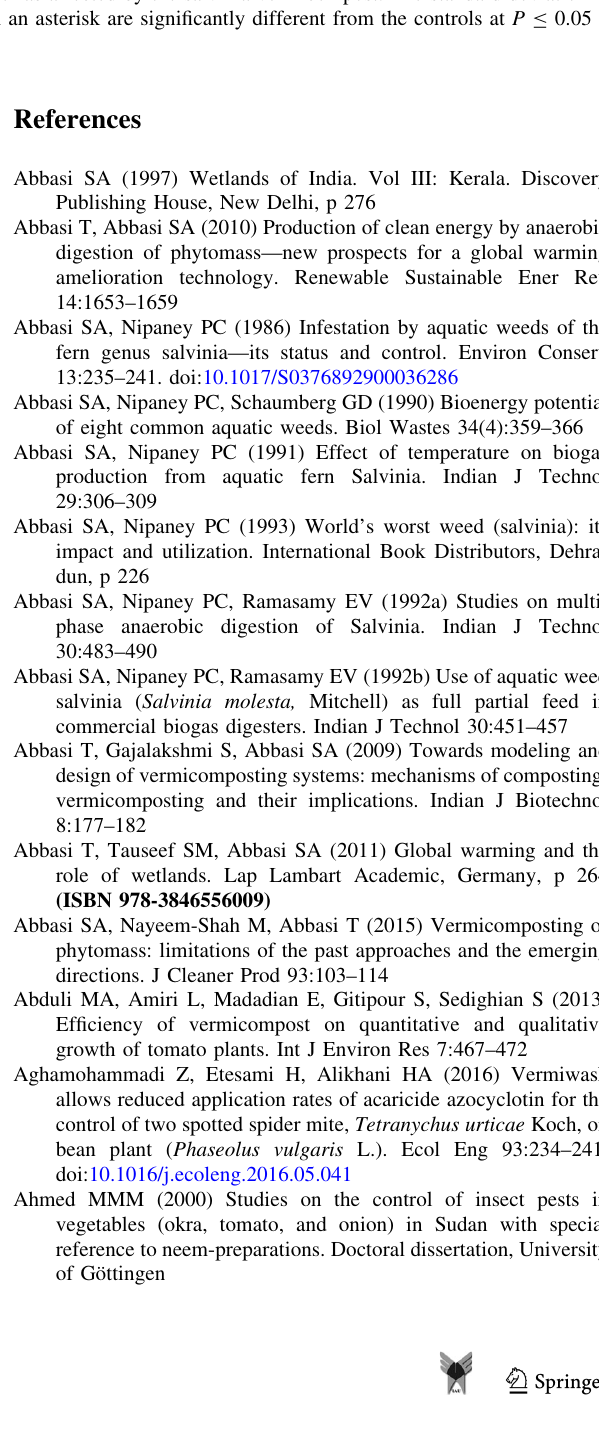
Fig. 4 Disease incidence and percentage of infected fruits in ladies finger as affected by the salvinia vermicompost. The standard deviation is indicated on the chart. The results shown in columns accompanied with an asterisk are significantly different from the controls at P